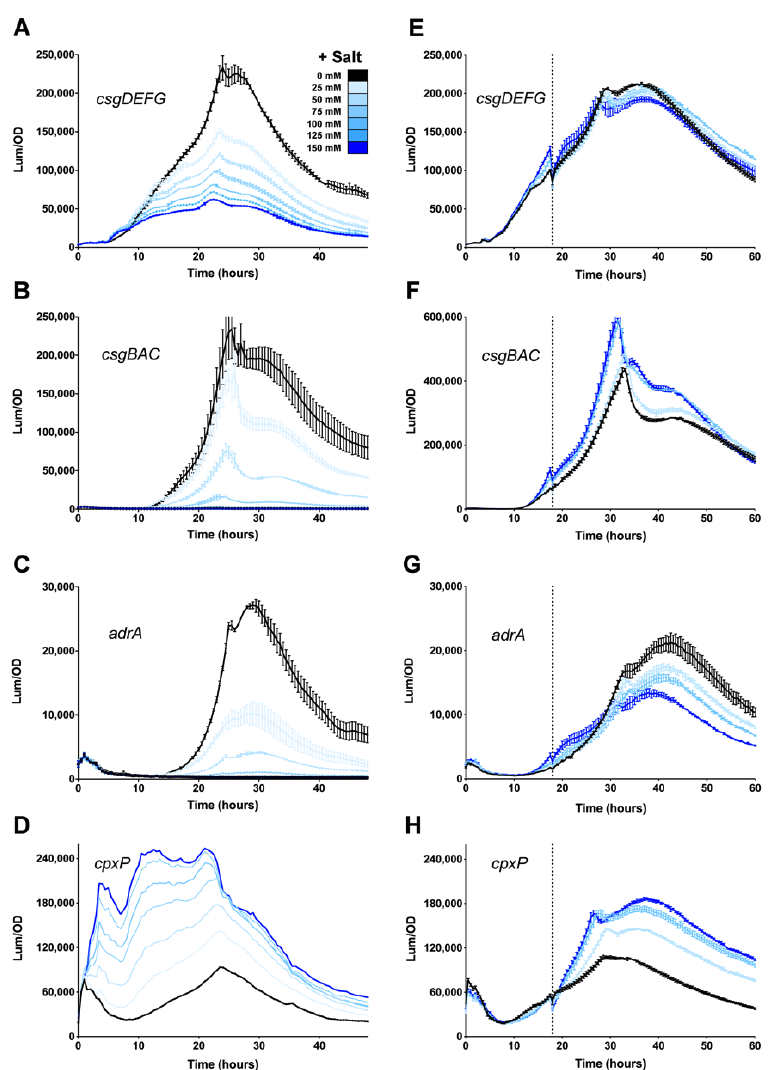
csgBAC ( B , F ), adrA ( C , G ), and cpxP ( D , H ) expression was measured in S. typhimurium 14028 during Figure 1. Response of the Salmonella csgD regulatory network to changes in osmolarity. csgDEFG ( A growth at 28 ◦ C in media premixed with 25, 50, 75, 100, 125 or 150 mM salt (A–D) or with 50, 100, and E ), csgBAC ( B and F ), adrA ( C and G ), and cpxP ( D and H ) expression was measured in S. or 150 mM salt added during growth (E–H; vertical line shows the time of addition at 18 h). For each graph, luminescence (light counts per second) divided by the optical density at 600 nm (Lum / OD) was plotted as a function of time with each curve representing a single growth condition. The mean and standard deviations are plotted from experiments performed in triplicate ( A – C , E – H ) or from a single representative experiment ( D